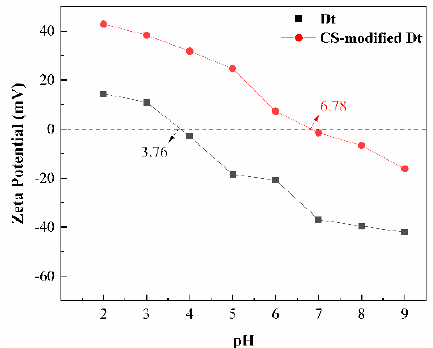
Figure 5. Zeta potential curves of Dt and CS-modified Dt.